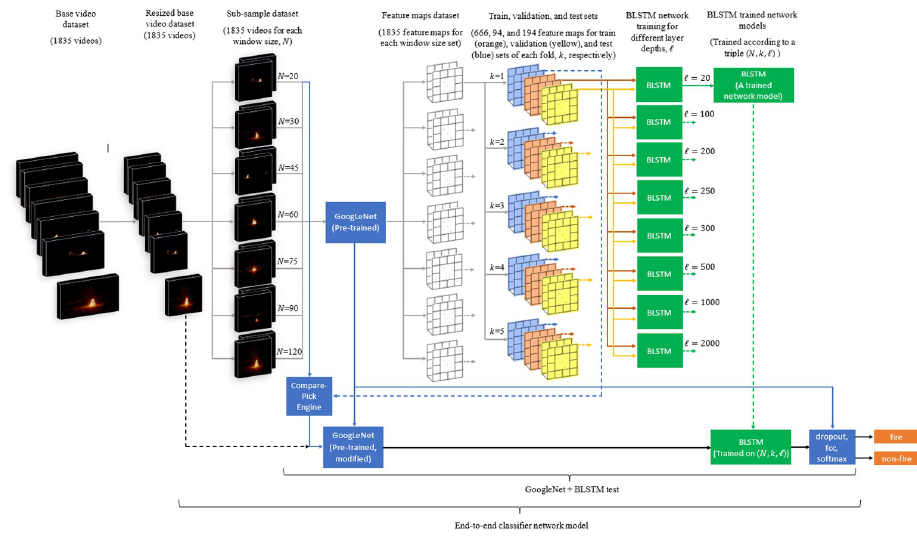
Fig 4. Stages of the proposed